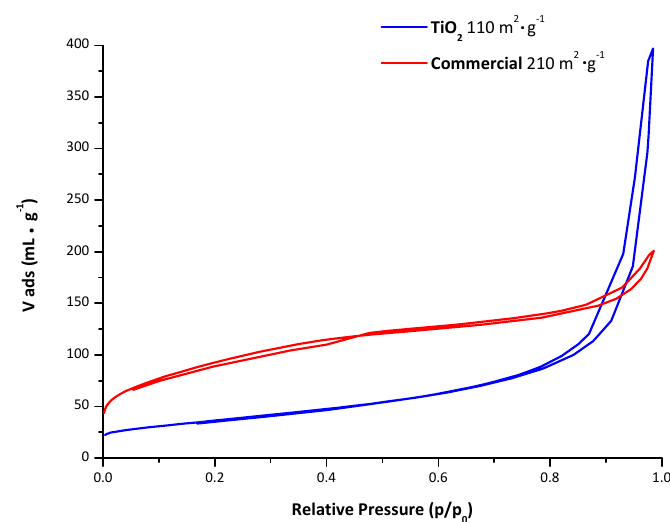
Figure 4. N 2 physisorption isotherms of unpromoted TiO 2 (red curves) and commercial titania (blue curves).